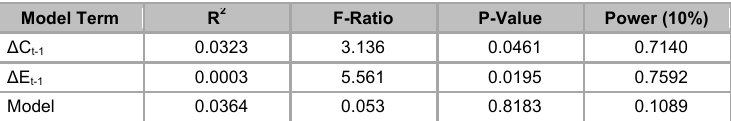
Analysis of variance on ∆ E t